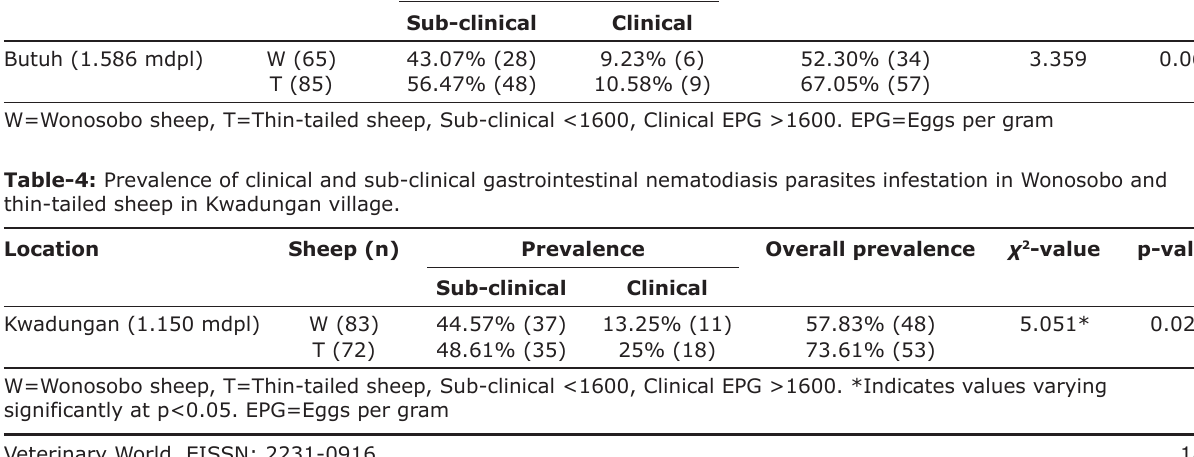
Table-3: Prevalence of clinical and sub-clinical gastrointestinal nematodiasis parasites infestation in Wonosobo and thin-tailed sheep in Butuh village. Location Sheep (n)